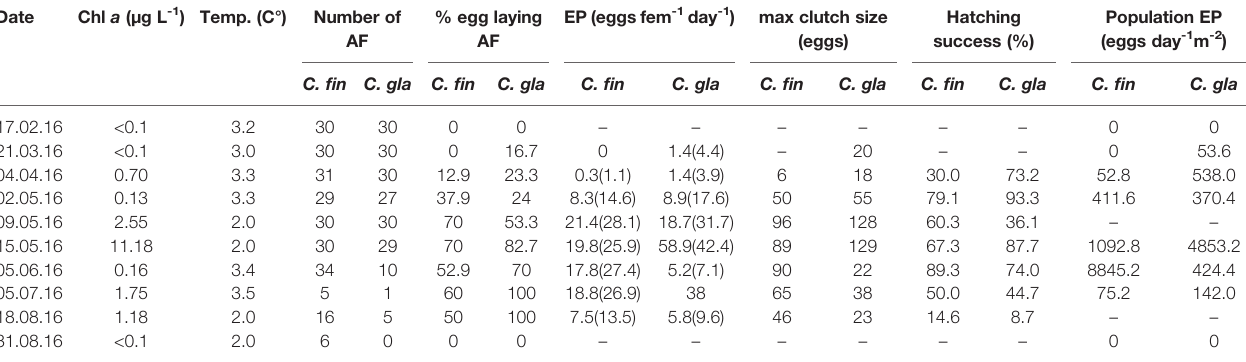
TABLE 3 | Egg production and hatching success for C. glacialis (C. gla) and C. fi nmarchicus (C. fi n) in Isfjorden from February to August